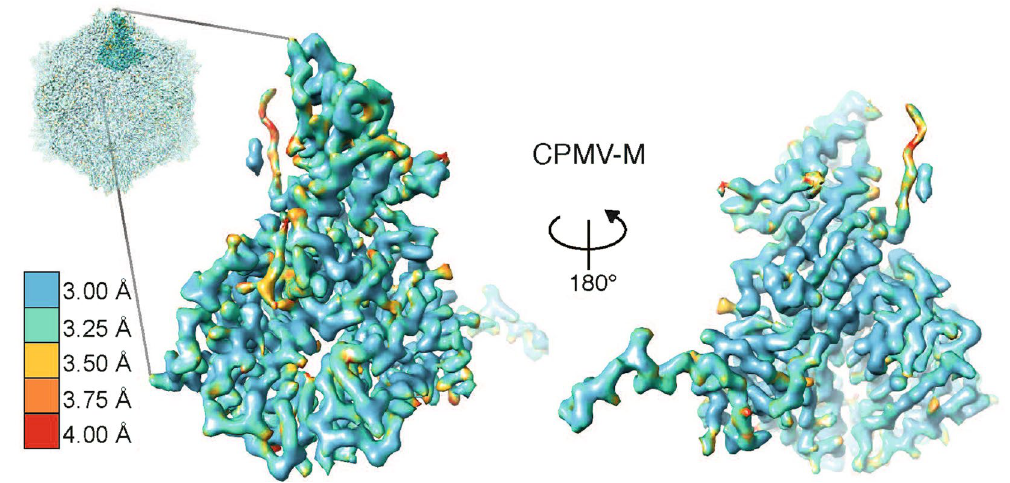
Figure 3. Local resolution of CPMV-M. A single asymmetric unit of CPMV-M (seen from outside the capsid) is shown coloured according to its local resolution. The interior of the asymmetric unit is also shown by rotating the asymmetric unit 180° around the y-axis. The highest resolution bin is 3.00 Å (blue) and the lowest resolution bin is 4.00 Å (red). A key is shown for reference.